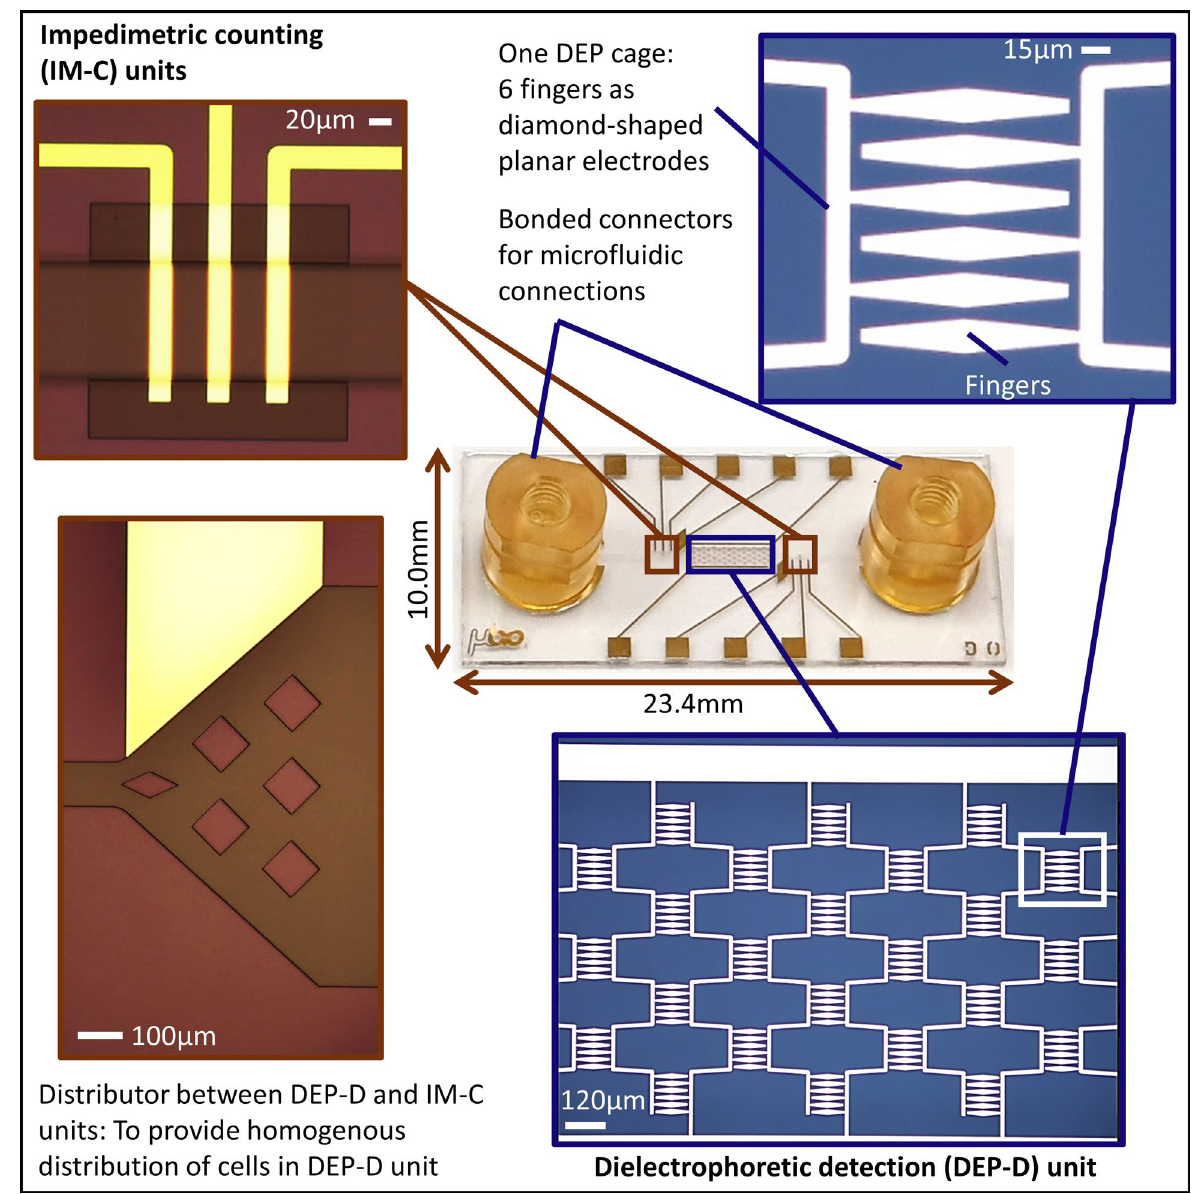
Figure 2. Fabricated LOC system emphasizing electrodes in DEP-D and IM-C units and flow buffer velocity, i.e. flow velocity, v m , is low enough, trapping of wild type cells becomes inevitable at this fre- quency. To prevent this, higher frequencies can be chosen to stay on the safe side. However, Re(f CM ) of K562/ imaR cells also decreased with increasing frequency (Fig. 3a, blue line). If the buffer velocity is high enough, the trapping of K562/imaR cells becomes impossible, which is not wanted. The frequency range in the case of LCB was determined to be between 43.7 MHz and 59.8MHZ at which K562/imaR cells had Re(f CM ) values of 0.25 and 0.10, respectively, to trap K562/imaR cells by pDEP. If the same comparison was achieved in a relatively HCB, having conductivity close to the cytoplasmic conductivity of K562/wt cells (σ = 200 mS/m), the frequency interval was defined between 1.4 MHz and 45.6 MHz. Additionally, the increase in Re(f CM ) of wild type cells was two-fold (from 0.008 to 0.016) and the rate of change in Re(f CM ) values of both cell types was low with reduced slope in Re(f CM ) plot (Fig. 3b). The level of MDR (i.e., high-level laboratory or clinically relevant models) may change the electrophysiologi- cal properties of cancer cells 32 . We have previously reported that high-level laboratory MDR model, K562/imaR cells, have 1.8 times higher ion concentration than that of K562/wt cells on average 25 . According to the literature, K562/wt cells have cytoplasmic conductivity in the range of 210–240 mS/m 17 . By using this reference value in the direct relation between cytoplasmic conductivity and ion concentration 33 , the estimated cytoplasmic conductivity values of K562/imaR, CCRF-CEM/wt, and CCRF-CEM/doxR cells were listed in Table 2. The working frequency